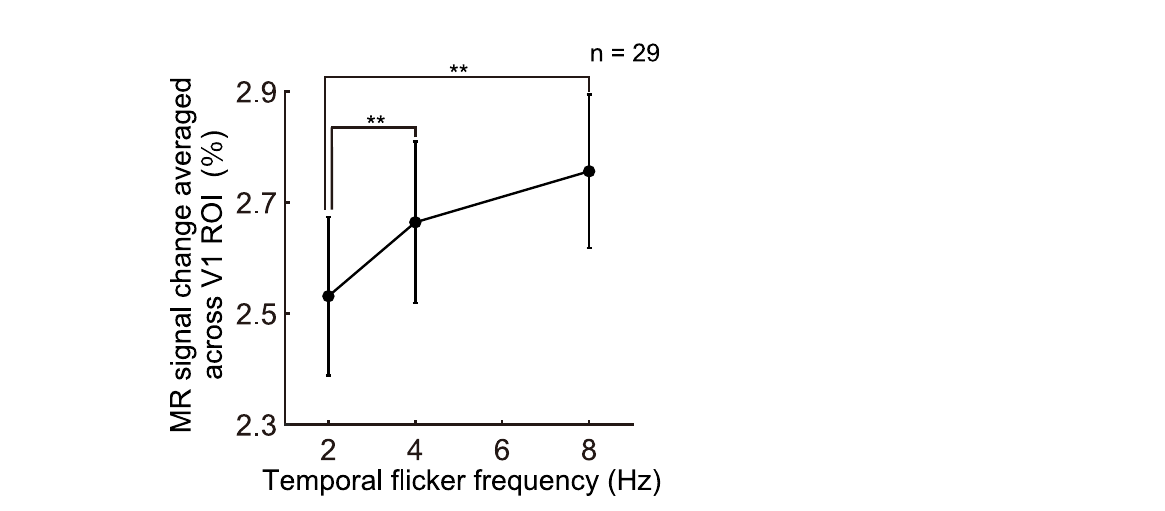
Fig 2. Magnetic resonance (MR) signal change in V1 increases with temporal flicker frequency. The MR signal change was averaged across V1 regions of interest (ROIs) for each participant and across 29 participants. The V1 ROIs were cortical vertices activated significantly (vertex-level uncorrected P < 0.001) within the V1 based on cytoarchitectonic atlas. Error bars represent the standard errors of the MR signal change. The main effect of the flicker